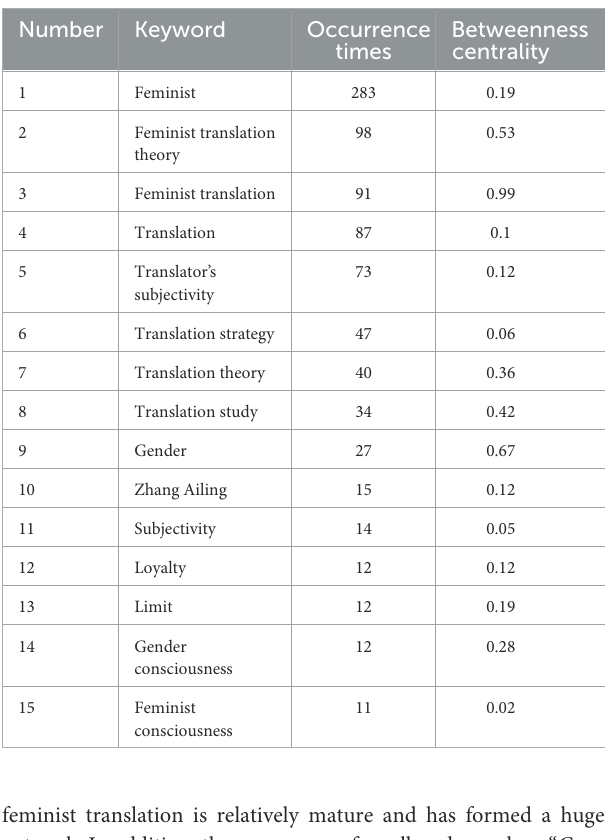
TABLE 3 Keywords co-occurrence frequency and their betweenness